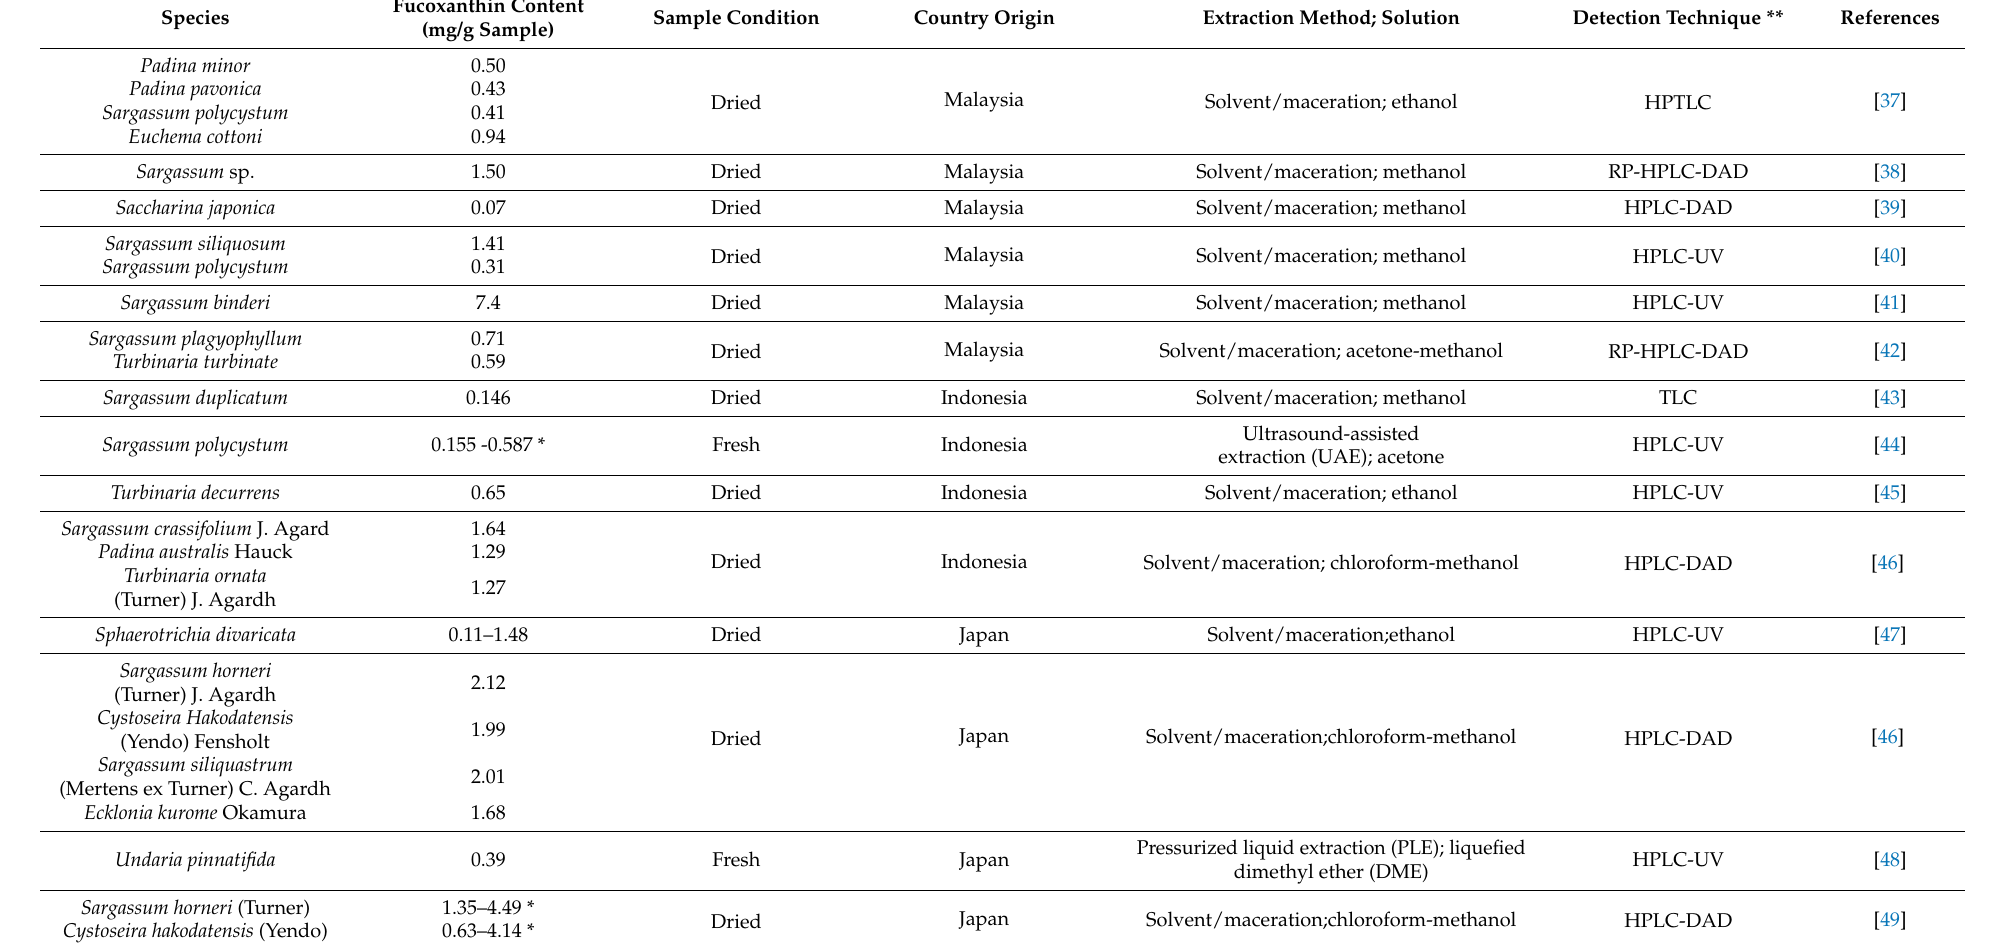
Table 1. Fucoxanthin content in various brown seaweed